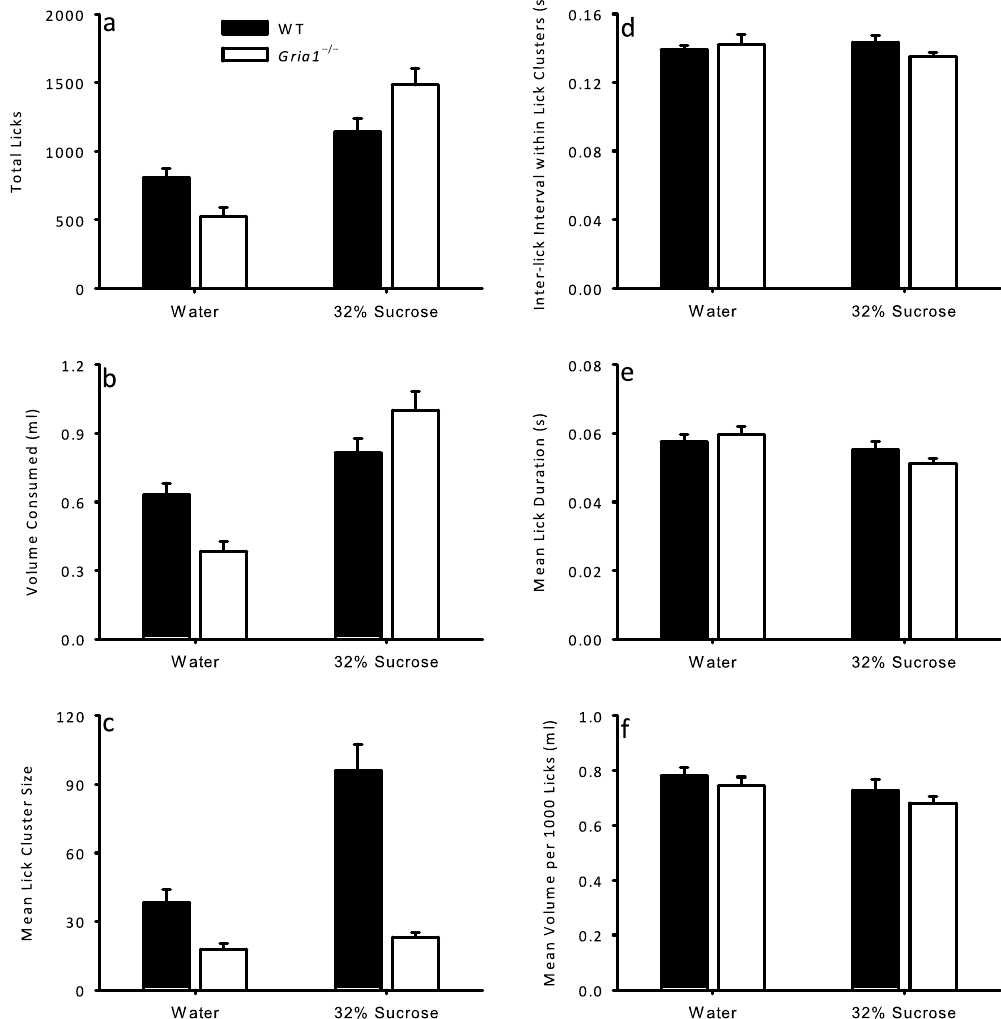
Figure 4. Licking behaviour during a 1 hour access to either water or 32% sucrose in thirsty mice. Six different measures of licking behaviour are given for WT (black bars) and Gria1 − / − (white bars) mice for consumption of water and 32% sucrose solution: ( a ) total licks; ( b ) volume consumed (ml); ( c ) mean lick cluster size; ( d ) inter- lick interval within lick clusters (s); ( e ) mean lick duration (s); ( f ) mean volume per 1000 licks (ml). Error bars indicate